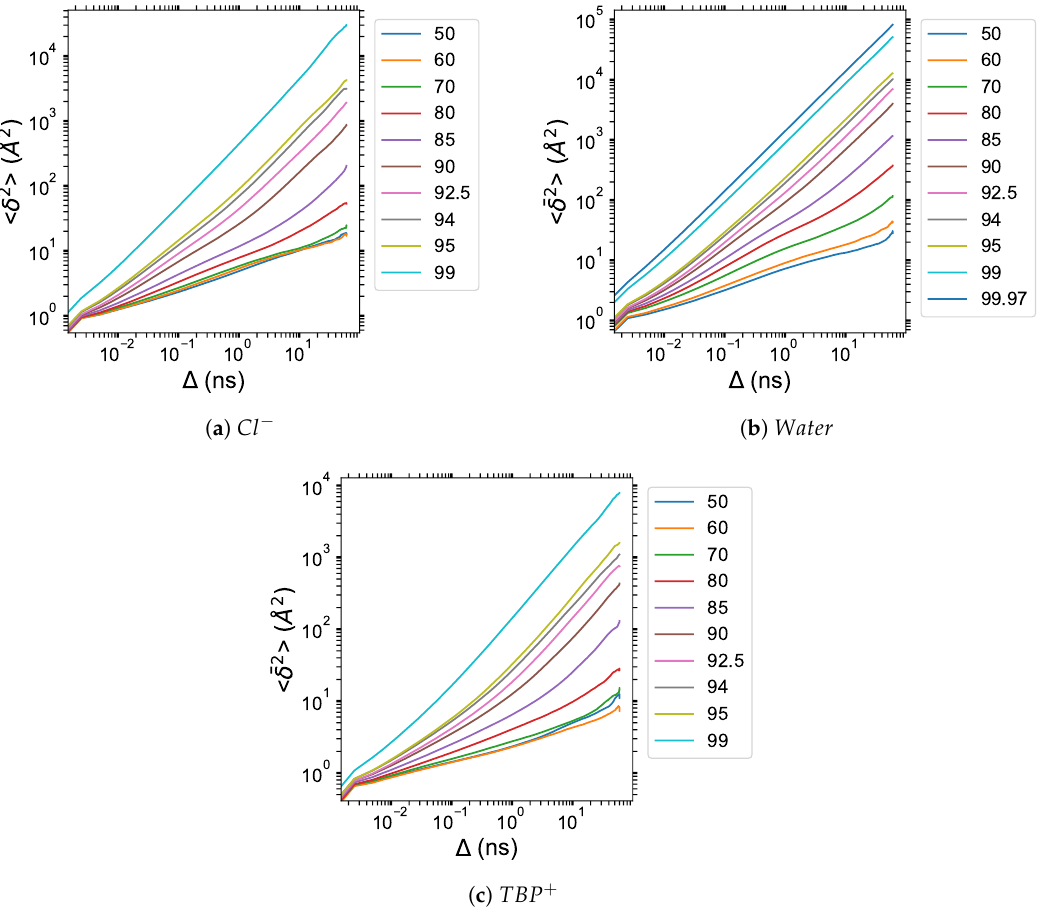
Figure A8. Particle-averaged TAMSDs of the TBPCl–water solution at p = 1atm and T = 300K as a function of water concentration for: ( a ) Cl − ; ( b ) water; ( c ) TBP +